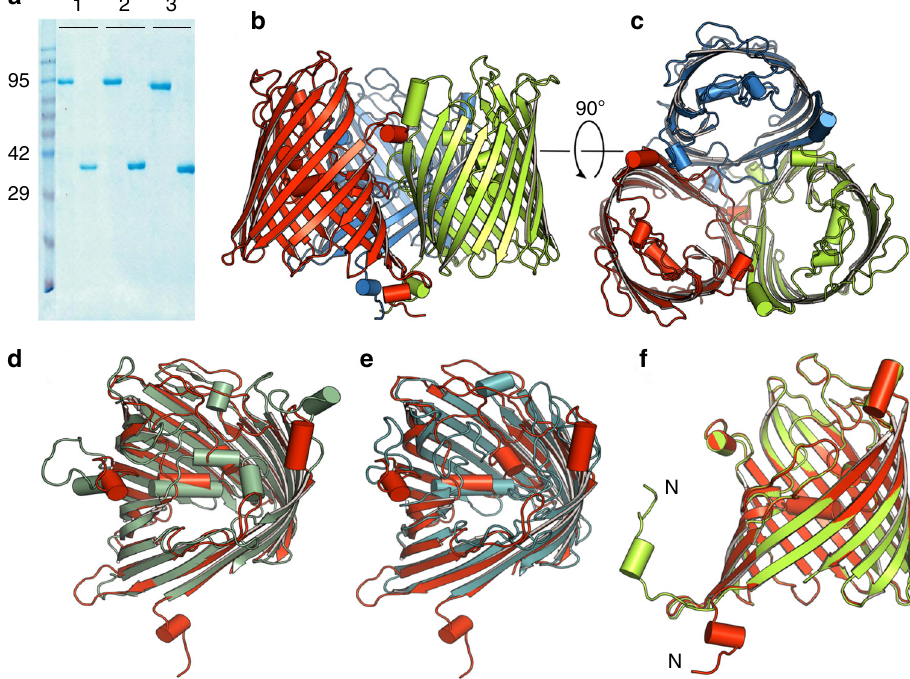
Fig. 1 X-ray crystal structure of in vitro-folded Vh ChiP. a SDS-PAGE gel of OM-expressed (native; 1), in vitro-folded (2) and truncated Vh ChiP (3) loaded both as non-boiled (left lanes) and boiled samples (right lanes). b Side view and c top view cartoon presentations of the in vitro-folded Vh ChiP trimer. d , e Top view superpositions of in vitro-folded Vh ChiP (red) with Neisseria meningitidis PorB (green; d ) and Delftia acidovorans Omp32 (blue; e ). f Superposition of in vitro-folded Vh ChiP (red) with OM-expressed Vh ChiP (green). The N-termini have been